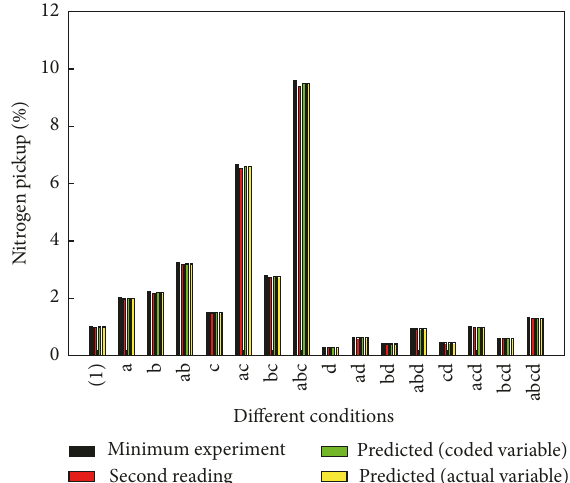
Figure 1: The variation between the predicted (coded and actual variables) and measured nitrogen pickup of low and high carbon